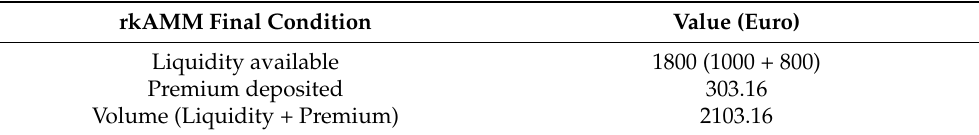
Table 5. Final rkAMM situation after collateral